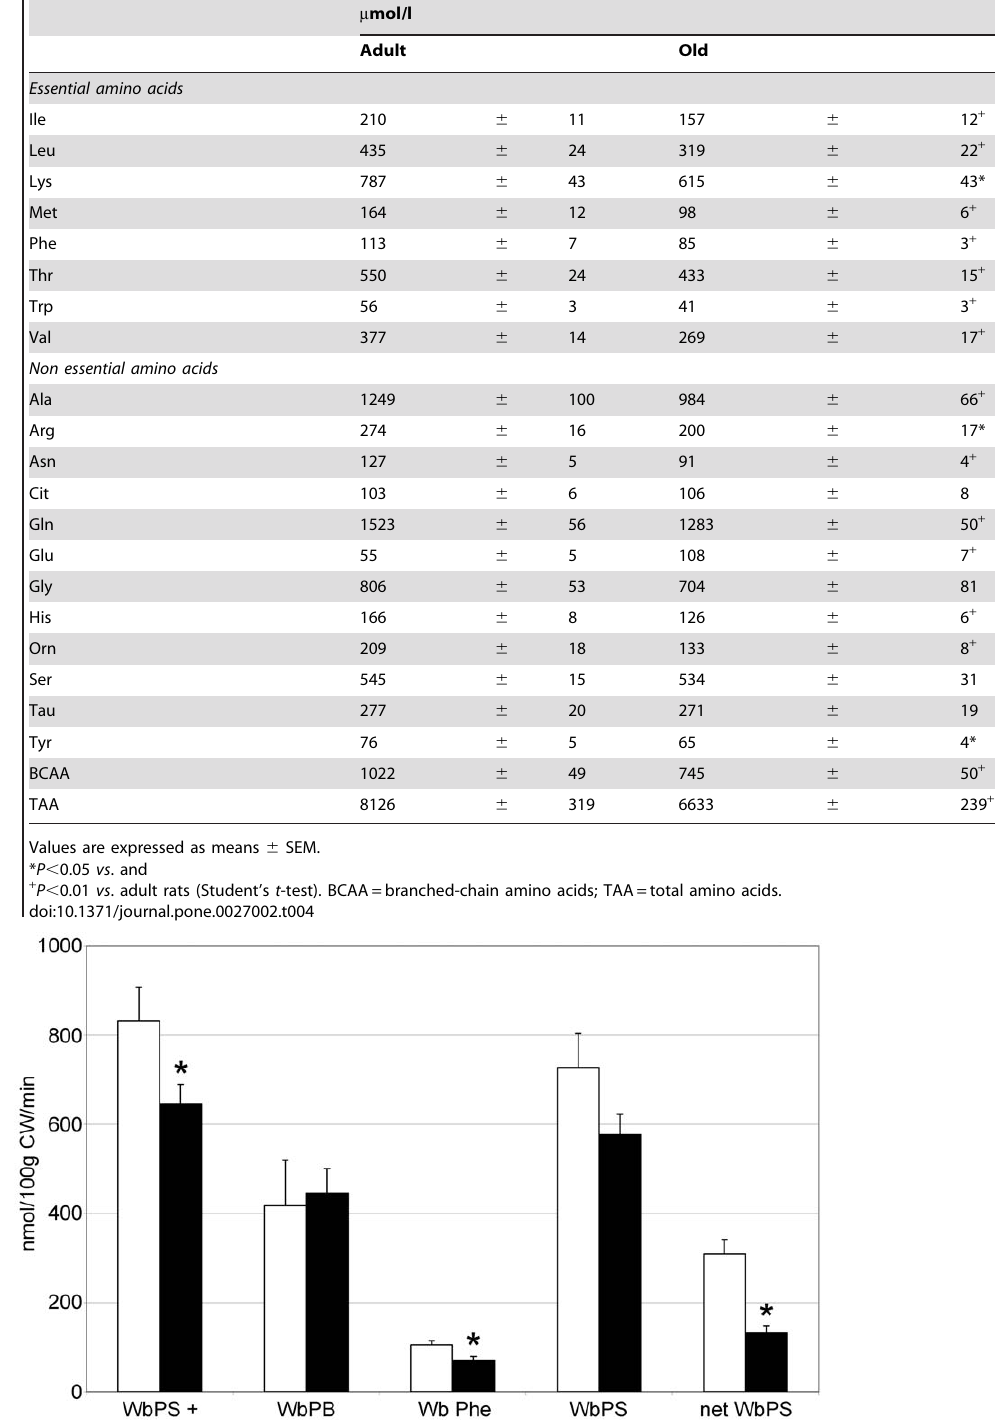
Arterial amino acid levels